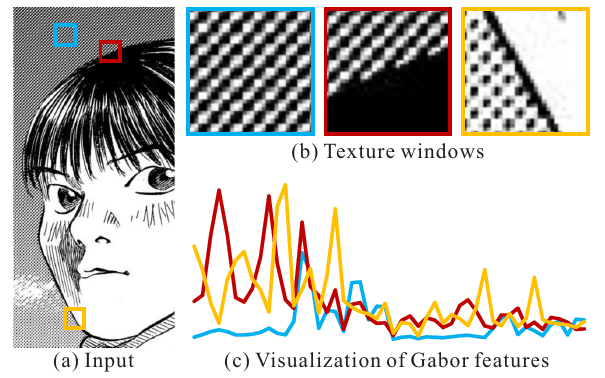
Fig. 2 For each texture region (e.g., the background region), interior pixels (blue box) and boundary pixels (red and orange boxes) exhibit different texture features.